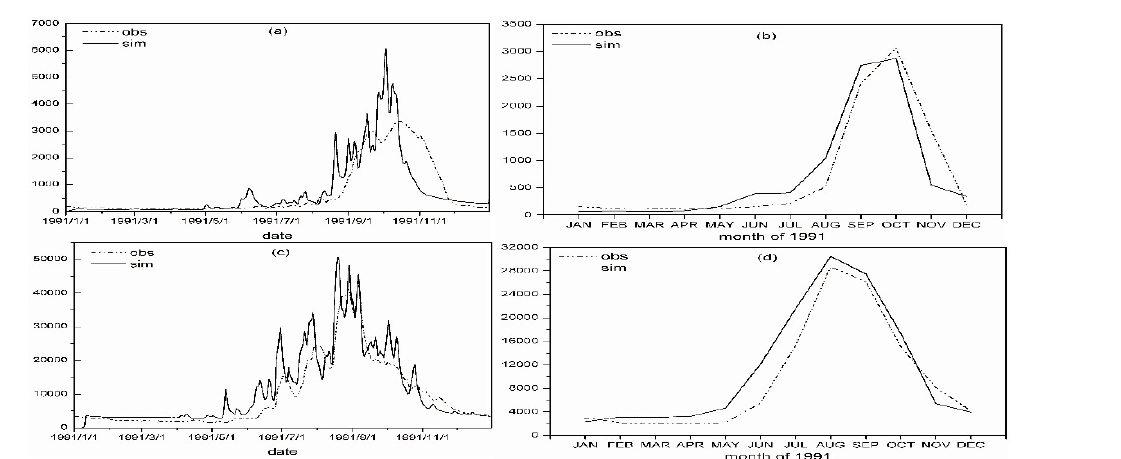
Fig. 2 Time series of daily and monthly discharge (m 3 /s) at the two stations during calibration period: daily series at Khong Chiam (a), monthly series at Khong Chiam (b), daily series at Ubon (c), daily series at Ubon (d).